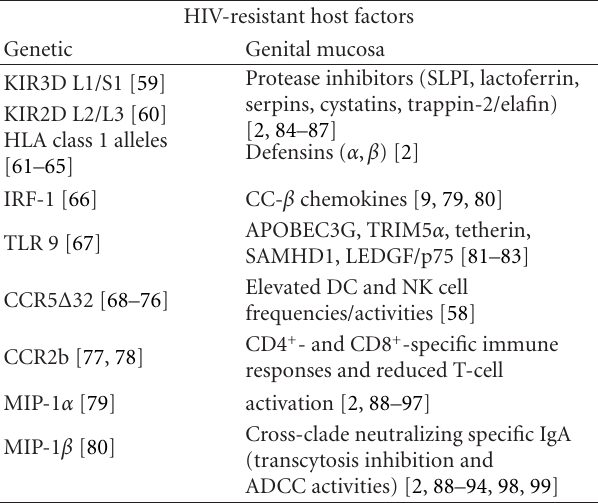
Table 1: Genetic and genital mucosa host factors associated with resistance to HIV-1 infection in several HESN